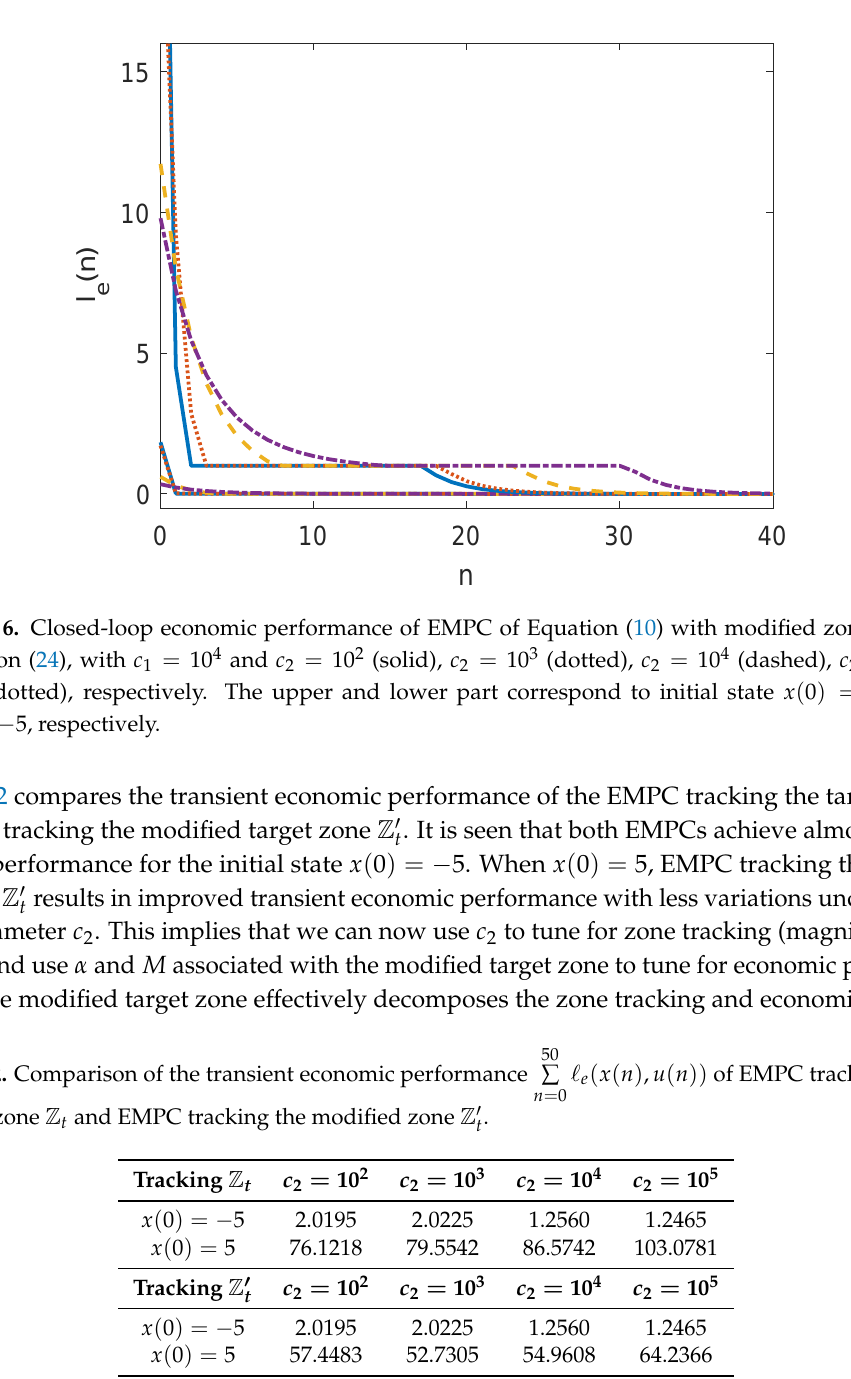
50 ∑ (cid:96) e ( x ( n ) , u ( n )) of EMPC tracking the n = 0